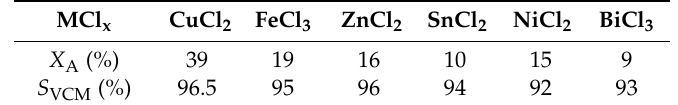
Table 2. Catalytic performance of di ff erent metal chlorides, using [PrMIm]Cl as the reaction medium.